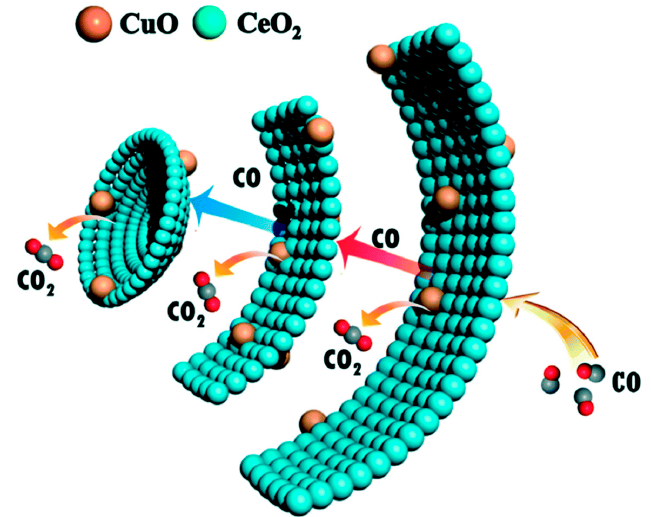
Figure 19. Schematic diagrams for CO-PROX over the CuO x /CeO 2 hollow microsphere catalysts with triple shells. Reproduced with permission from Reference [260]. Copyright© 2019, Royal Society of Chemistry.